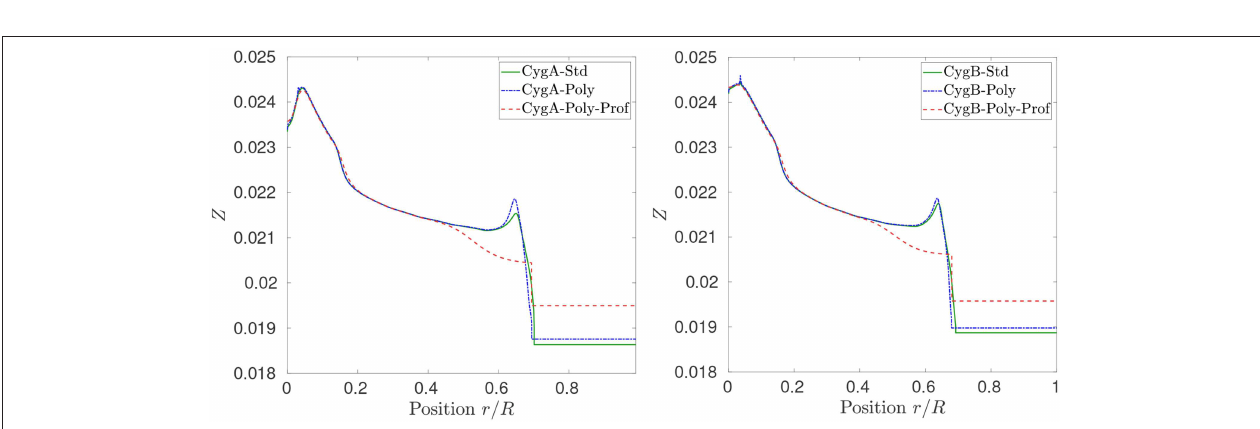
FIGURE 11 | Temperature gradient profiles as of function of r / R for the 16Cyg A and B models considered in this study.